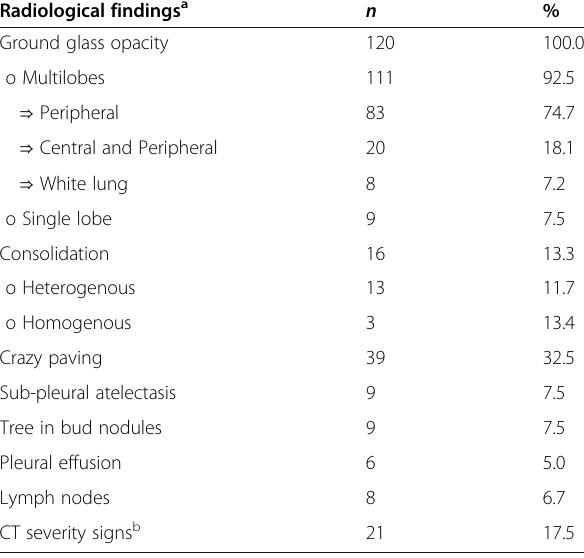
Table 3 The radiological signs of the studied cases